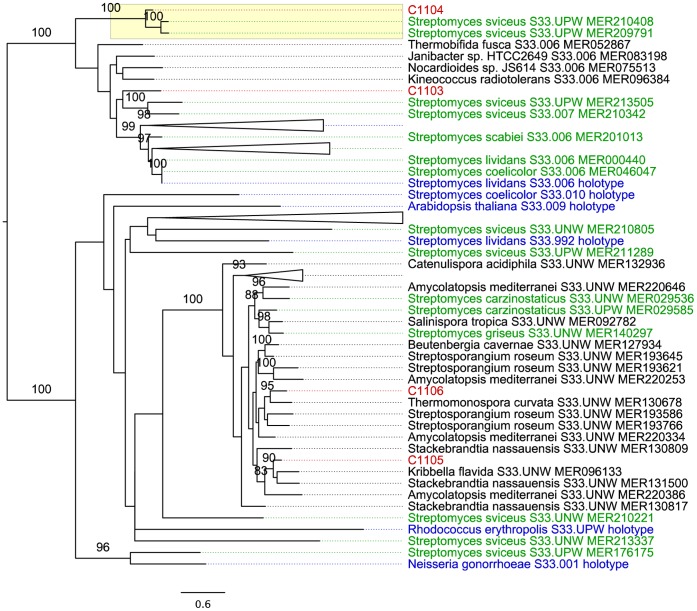
Phylogeny of prolyl aminopeptidases.Propyl aminopeptidase consensus sequences are coloured red (Contigs C1103–C1106). The clade containing contig C1104 and two Streptomyces species is shown in yellow. The Streptomyces reference sequences from MEROPS S33 family are shown in green and family holotypes in blue. MEROPS id is indicated for each sequence. The phylogeny was inferred using the maximum likelihood method. Numbers refer to bootstrap support values higher than 75%.